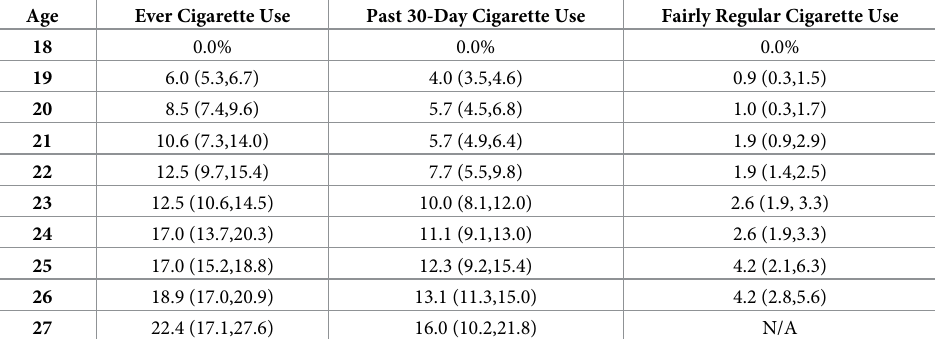
Table 2. Estimated cumulative incidence (and 95% confidence intervals) a of the age of initiation of cigarette out- comes for young adult (18–24 years old) never cigarette users at their first wave of PATH adult participation �